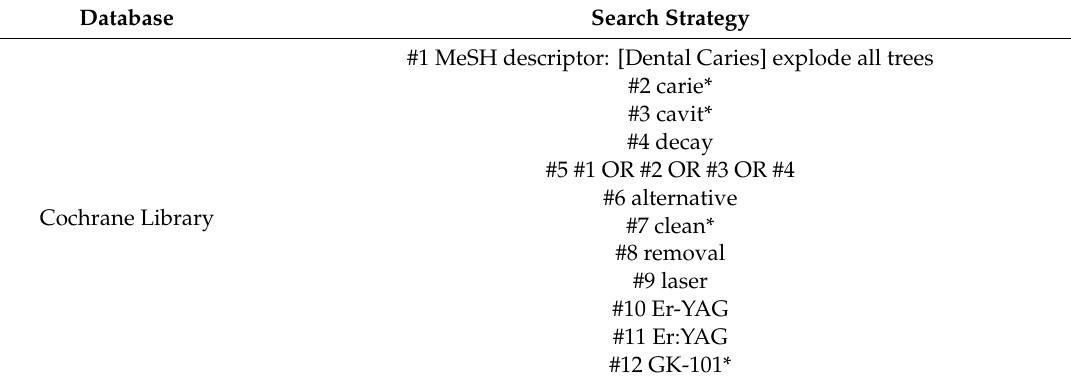
Table 3. Research strategy